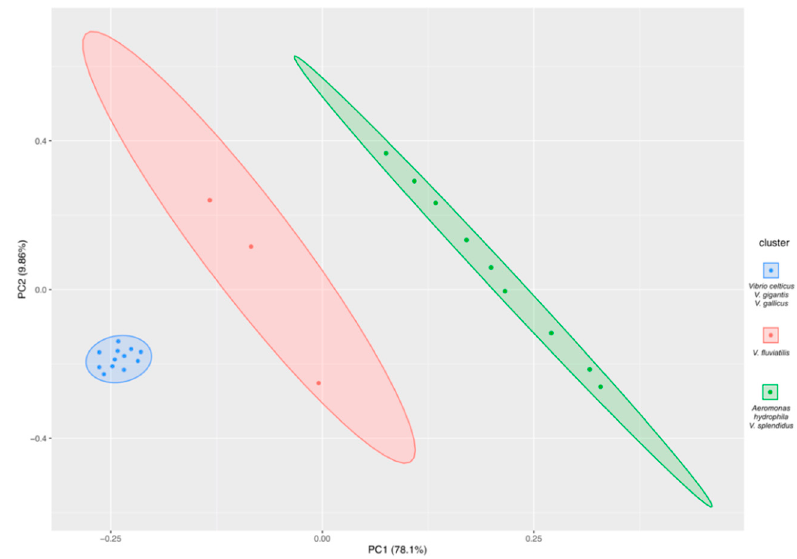
Figure 4. Principal component analysis of biochemical features of Vibrio spp. strains based on phenotypic species identification (API ® 20E test). The blue cluster contains most of the strains that were similar in biochemical features ( Vibrio celticus , V. gigantis , and V. gallicus ). The red cluster contains V. fluvialis , whereas the green cluster contains Aeromonas hydrophila and V. splendidus . Confidence ellipses (95%) plot convex hull values of each